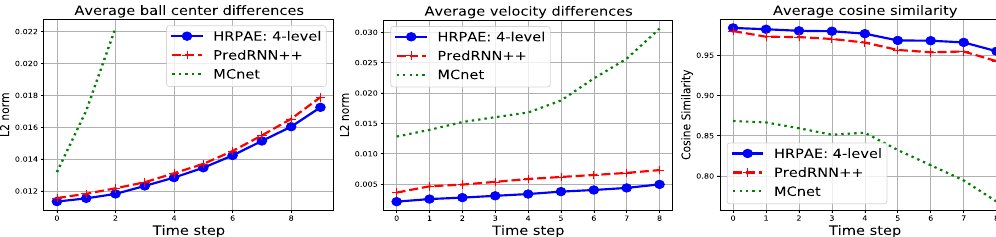
Figure 3. Experimental results on Bouncing Balls. This figure shows the ball center differences, velocity differences and cosine